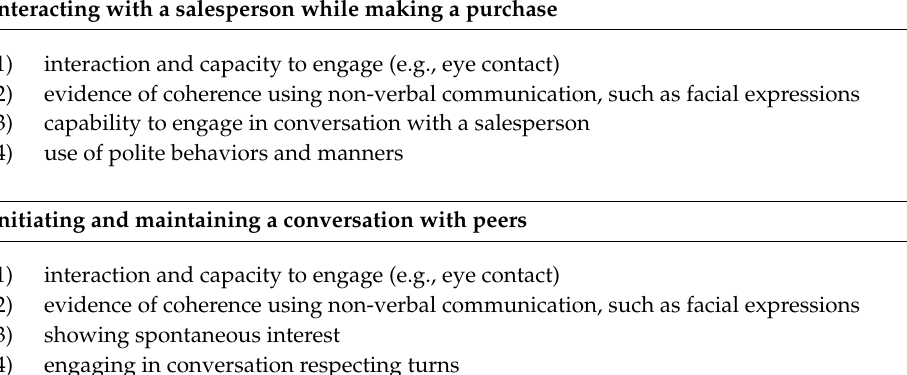
Table 2. Subdivision of tasks.